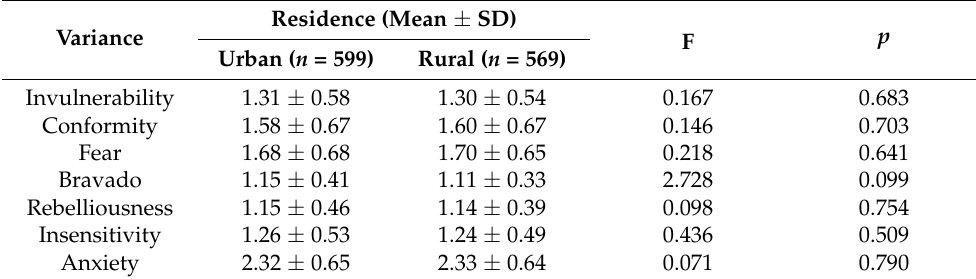
Table 4. The difference in psychological symptoms across the residences.